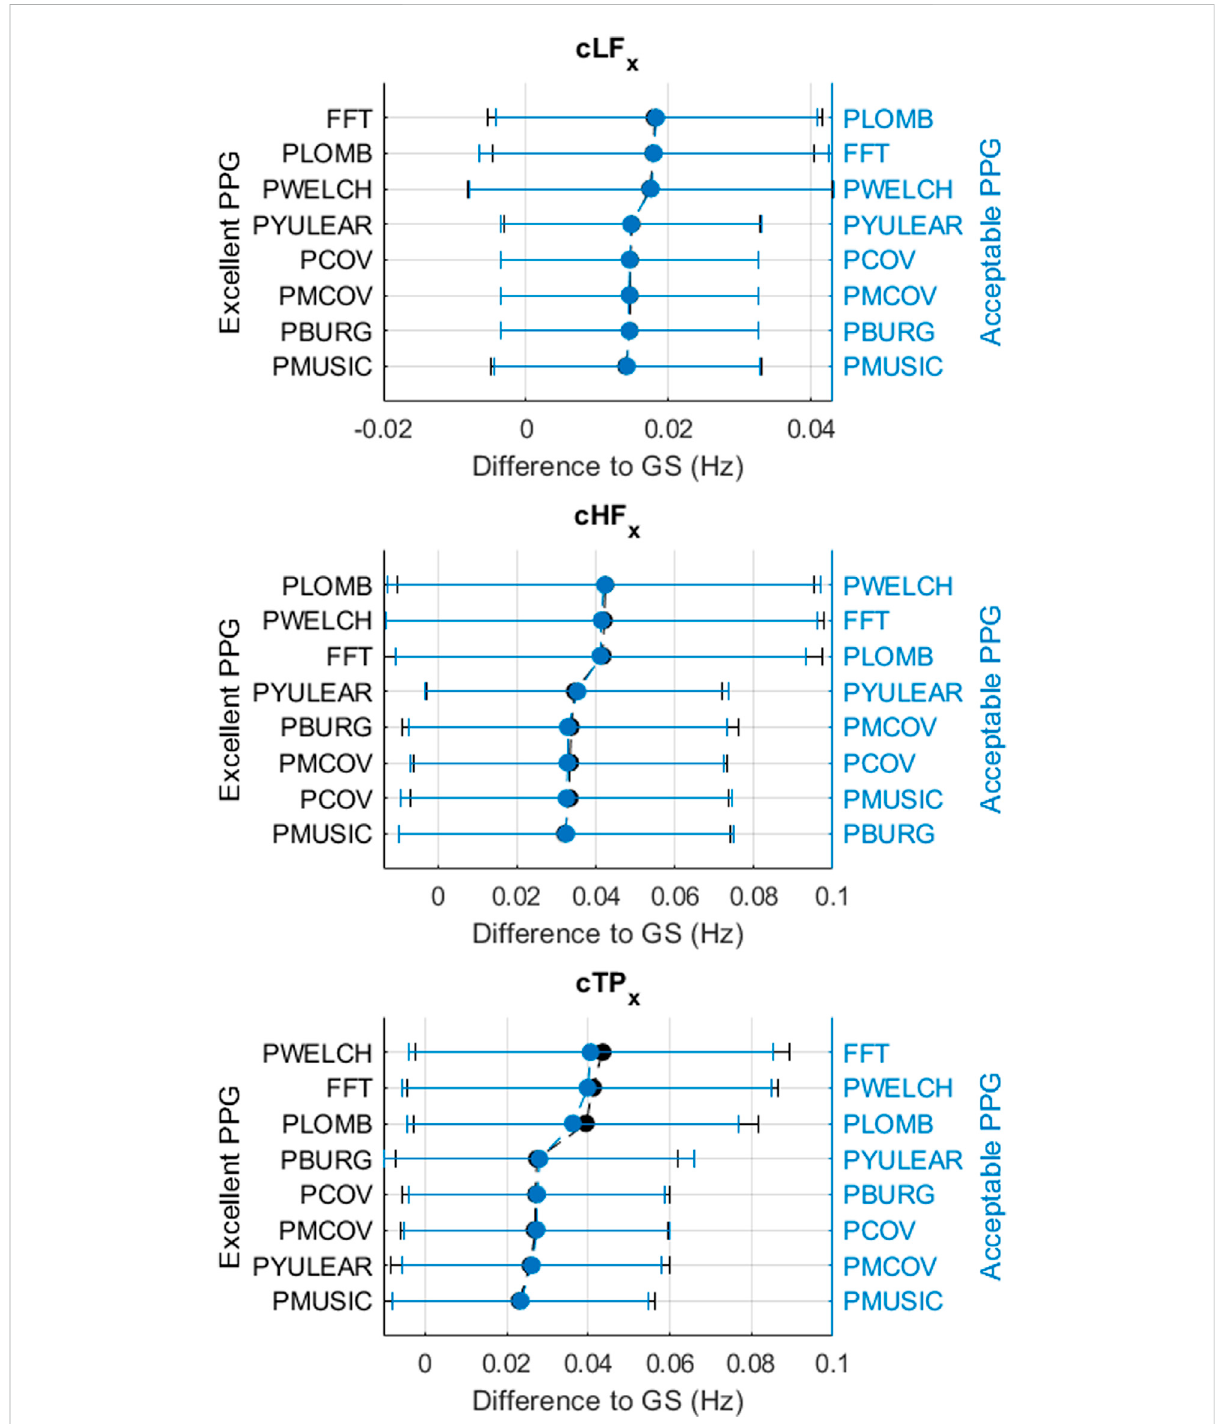
FIGURE 5 Mean and standard deviations of the differences obtained by comparing pulse rate variability x -coordinates of centroid-related frequency- domain indices obtained from extracted and gold-standard